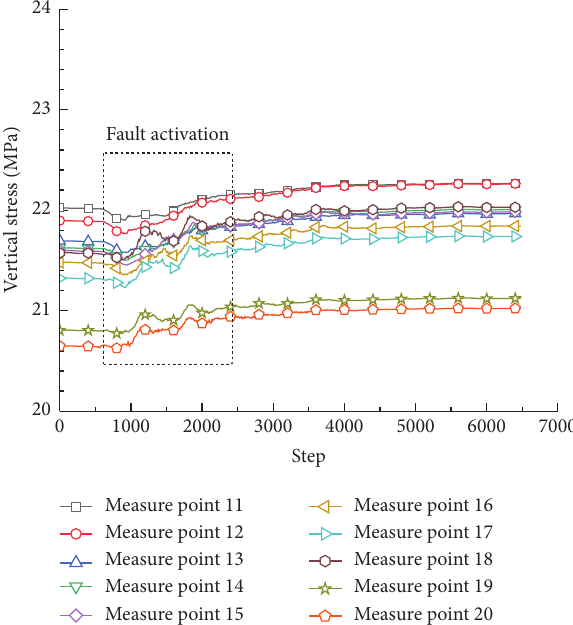
Figure 9: Vertical stress of fault measuring